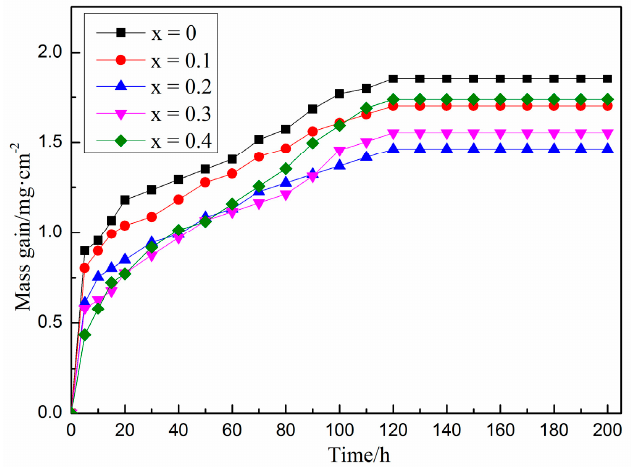
Figure 6. Fe-25Mn-9Al-8Ni-1C-xTi alloy oxidation weight gain curve. XRD tests were carried out on the surface of the alloys with different Ti content after oxidation, and the results are present in Figure 7a. As can be seen from Figure 7a, after oxidation of Fe-25Mn-9Al-8Ni-1C-xTi alloy at 600 ◦ C, the series of oxide layers mainly contain oxides such as Fe 2 O 3 (JCPDS: 33-0664), Al 2 O 3 (JCPDS: 51-0769), and Mn 2 O